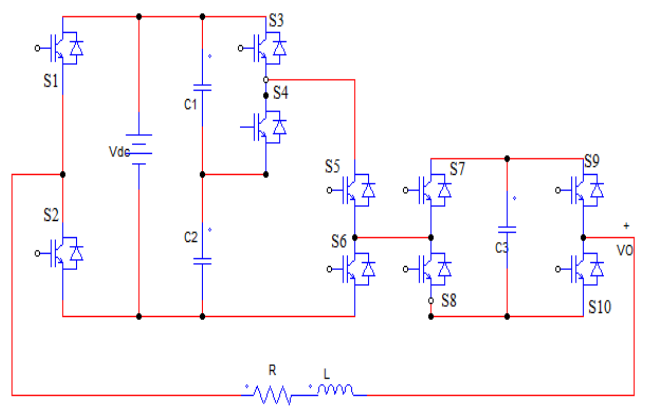
Figure 12. Ten-switch, nine-level topology [61] .